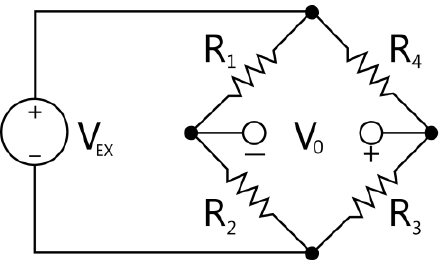
Figure 5. Complete Wheatstone bridge.